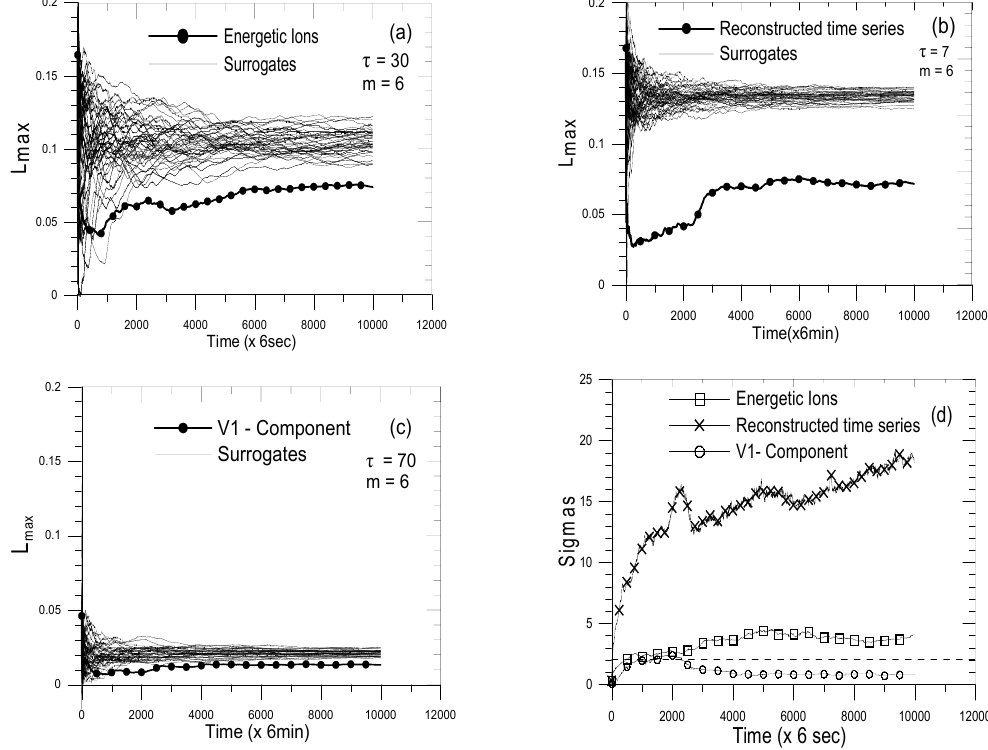
Figure 3 Fig. 3. (a) The largest Lyapunov exponent ( L max ) for the surrogate data and the energetic ions’ time series as a function of the evolution time estimated for delay time τ = 30 and embedding dimension m = 6. (b, c) The same with (a) but for the reconstructed and the V 1 -component time series of the energetic ions’ time series with embedding dimension m = 6 and corresponding delay time τ = 7 , 70. (d) The significance of the discriminating statistic of the largest Lyapunov exponent as a function of the evolution time, for the energetic ions its reconstructed and its V 1 -component time